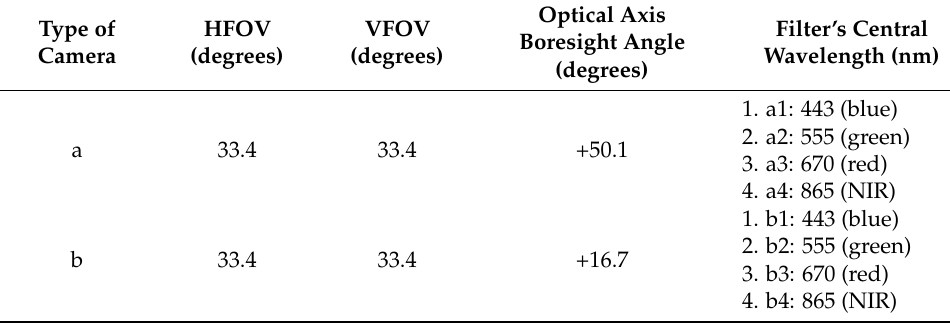
Table 6. Main features of the HORUS payload